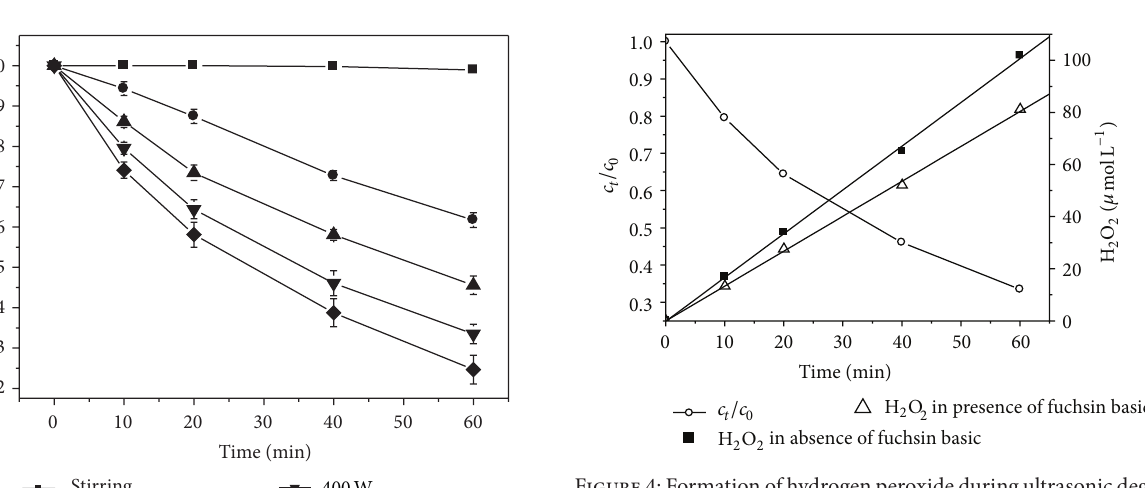
Figure 4: Formation of hydrogen peroxide during ultrasonic degra- dation of fuchsin basic (dye concentration = 10 𝜇 molL −1 , ultrasonic power = 400 W, ultrasonic frequency = 25 kHz, pH = 6.5, and tempetature = 22 ∘